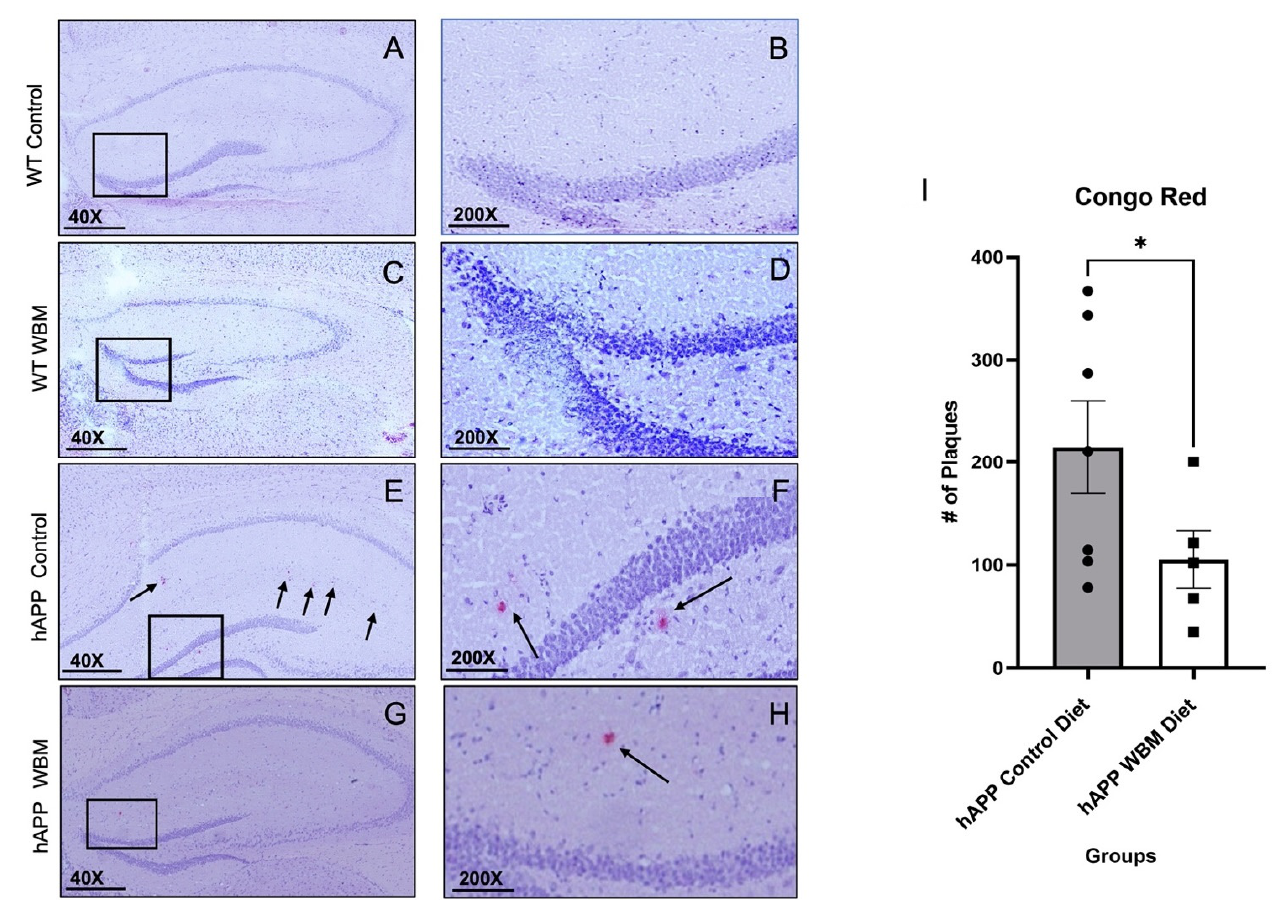
Figure 2. Congo red staining in the Hippocampus ( n = 12). ( A – D ) No plaques were found in WT mice, as expected. Subfiigures ( B , D , F , H ) are expanded versions of the boxes in subfigures ( A , C , E , G ); the arrows indicate specific plaques within the medial hippocampal area. ( E , F ) Congo Red staining in an hAPP control diet mouse. ( G , H ) Congo Red staining in an hAPP mouse on the WBM diet. ( I ) hAPP mice on the WBM diet had significantly fewer plaques than those on the control diet ( p < 0.05). (* p < 0.05). Scale bar at 40× magnification is 500 μ m and at 200× magnification the scale bar is set to 100 μ m.